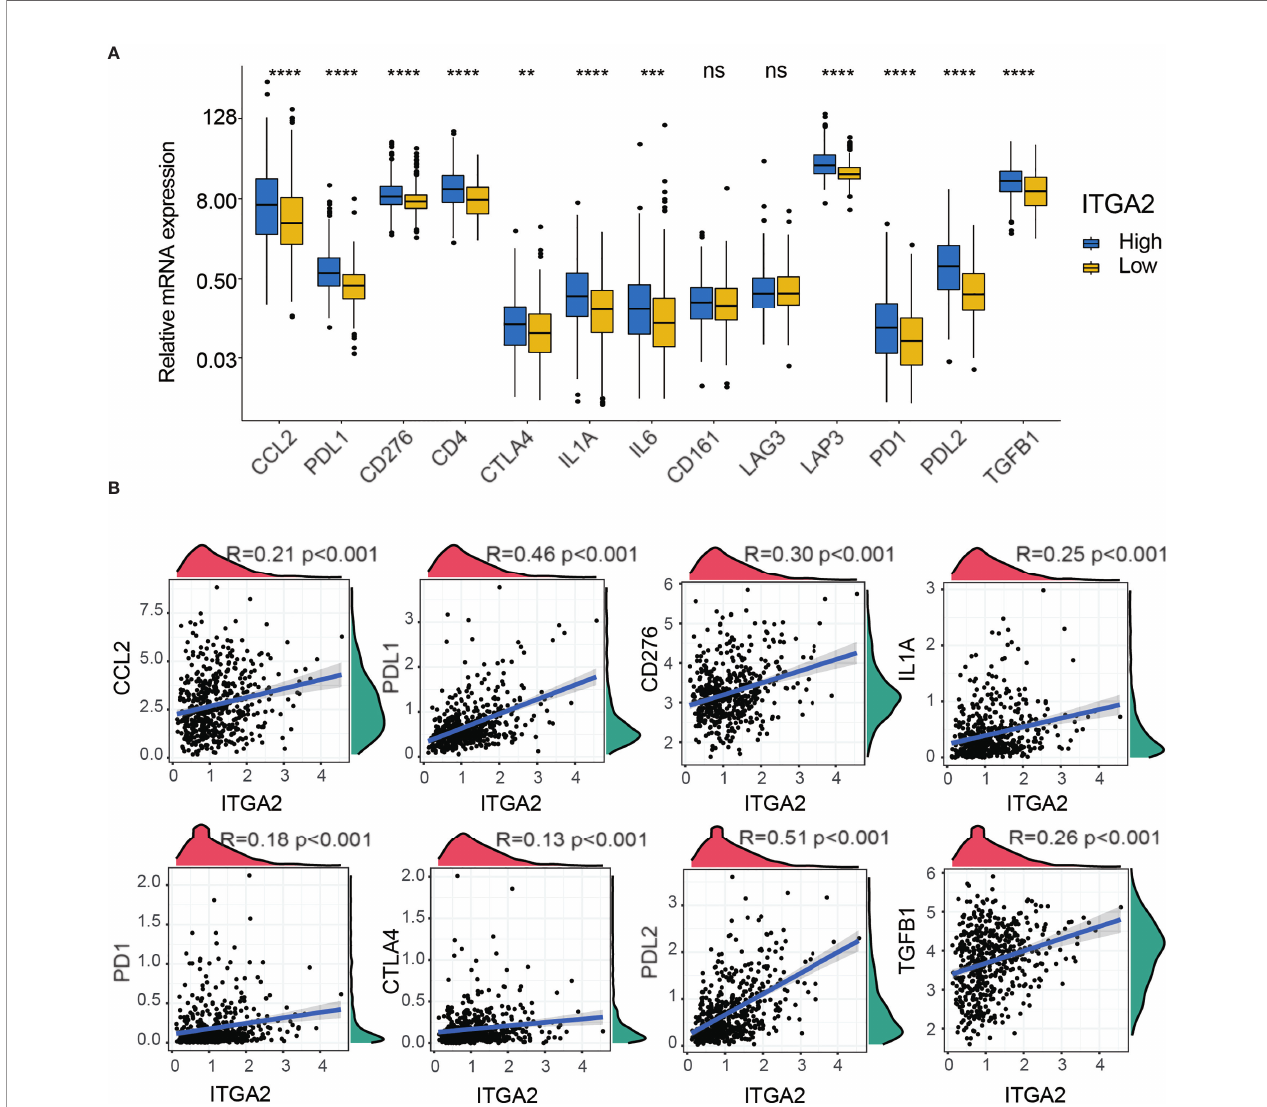
FIGURE 7 | The correlation pro fi ling of immune checkpoints. (A) Differential analysis of several immune checkpoint expression levels between high- and low-integrin alpha-2 (ITGA2) expression levels. (B) Correlation analysis between ITGA2 and eight selected immune checkpoint expression levels. **p < 0.01, ***p < 0.001, and ****p < 0.0001. ns